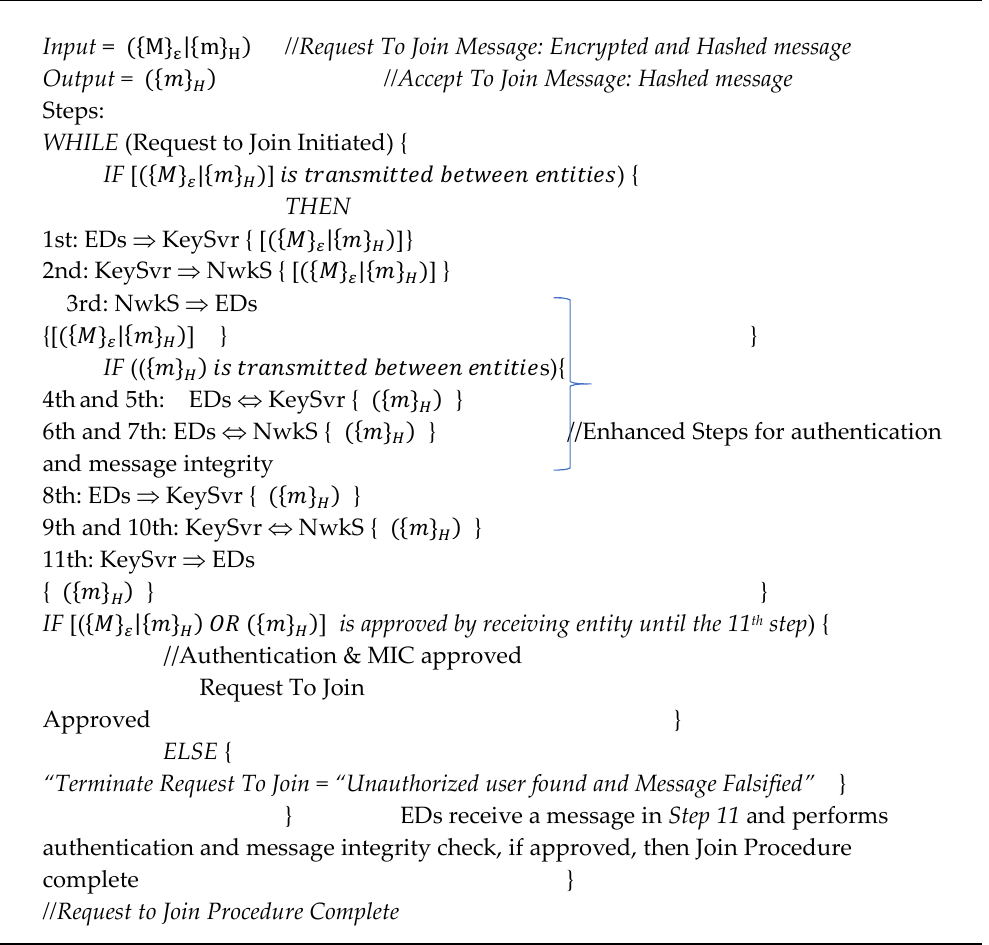
Algorithm 2: Enhanced-TKMS Algorithm